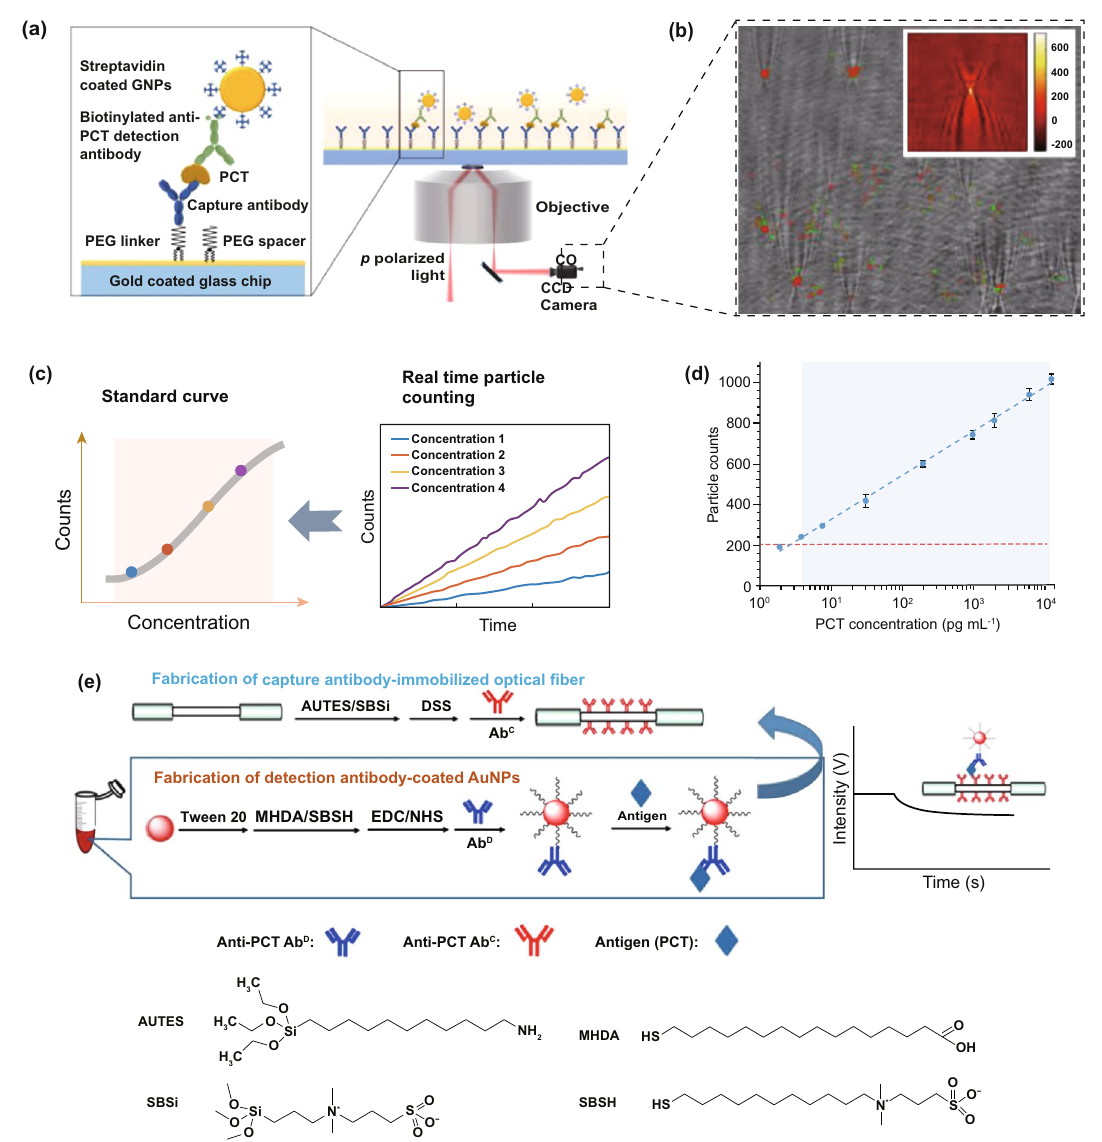
Fig. 9 Nanodiagnostic platforms based on nanoplasmonic technology for PCT detection. TD immunoassay. a Construction and mechanisms of TD immunoassay for PCT detection. b Representative image of TD immunoassay for PCT detection using nanoplasmonic imaging. c The signal transduction from real-time particle counting to PCT concentrations can then be employed to draw standard curve. d Standard curve of PCT detection generated by TD immunoassay showing a favorable linear relationship between particle counts and PCT concentrations. Reproduced with permission from Ref. [154]. Copyright 2019 American Chemical Society. e Fiber optic nanogold-linked immunosorbent assay (FONLISA): fabrication of capture platforms and nanoplasmonic probes. Reproduced with permission from Ref. [152]. Copyright 2020